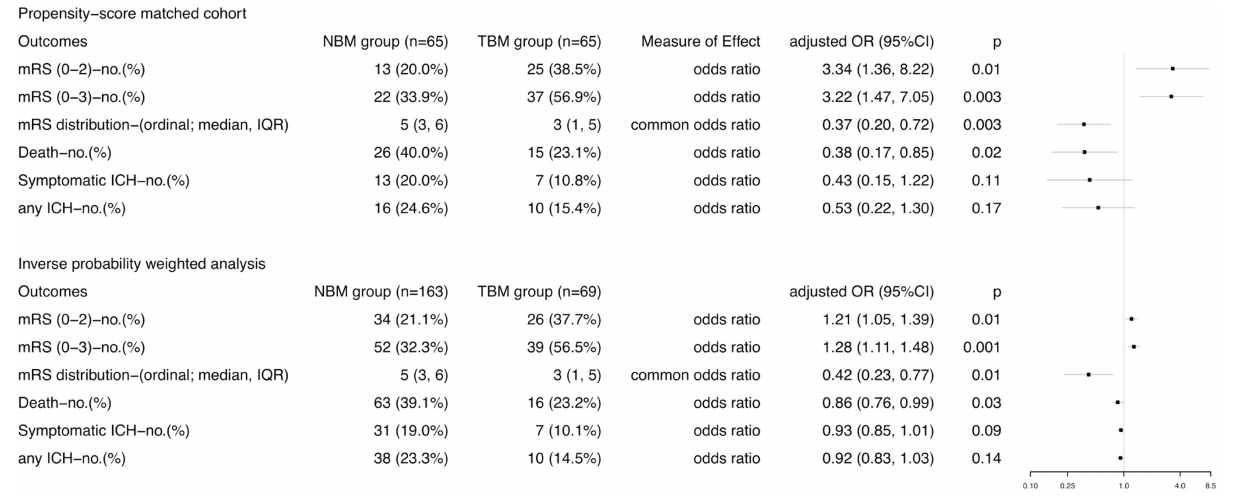
FIGURE 3 | Comparisons in efficacy and safety outcomes according to BP management approach in stroke patients treated with thrombectomy in PSM and IPWRA analyses. Primary outcome measure was the excellent outcome, which was defined as 90-day mRS score 0-2. mRS, modified Rankin scale; ICH, intracranial